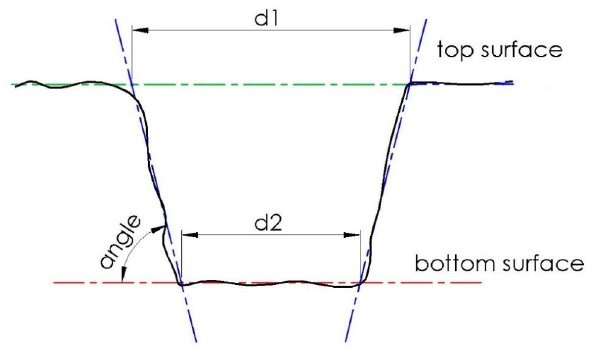
estimated in the same way. The characteristic points of in- tersection of theoretical lines allowed to estimate the di- ameters (d1, d2) and the angle of inclination of the side surfaces. These measurements were made on the basis of a series of ten cross-sections for each sample using the